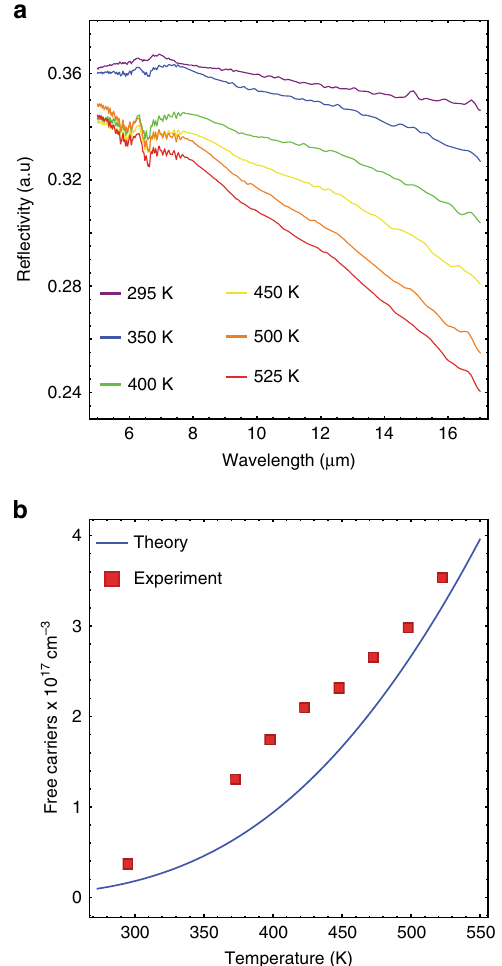
Fig. 1 Thermal free-carrier refraction in intrinsic InSb. a Re fl ection spectra of an intrinsic InSb fi lm at various temperatures. The long-wavelength roll-off is due to Drude dispersion and increases with temperature. b Temperature- dependent free-carrier concentrations inferred from fi ts to the curves in Fig. 1a ( square red dots ) show good agreement with fi t-free models of thermally activated carriers ( blue